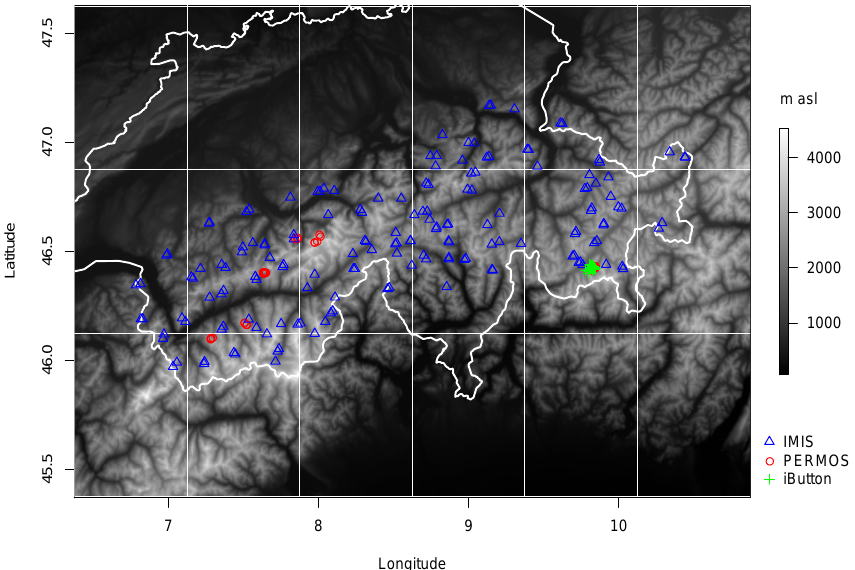
Figure 2. Experiment domain centred on the Swiss Alps together with evaluation data set locations. The ERA-I grid is overlaid in white.